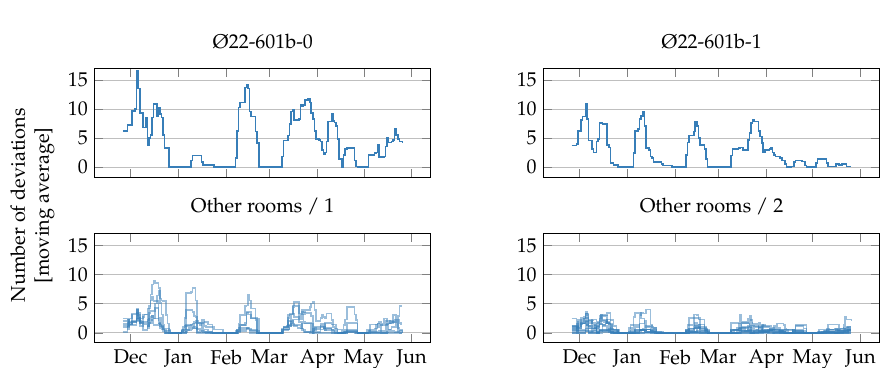
Figure 6. Moving average of deviations for ventilation unit 1. In the first two plots, the rooms which frequently deviate from the common behaviour are shown separately. The rest of the rooms are shown together in the last two